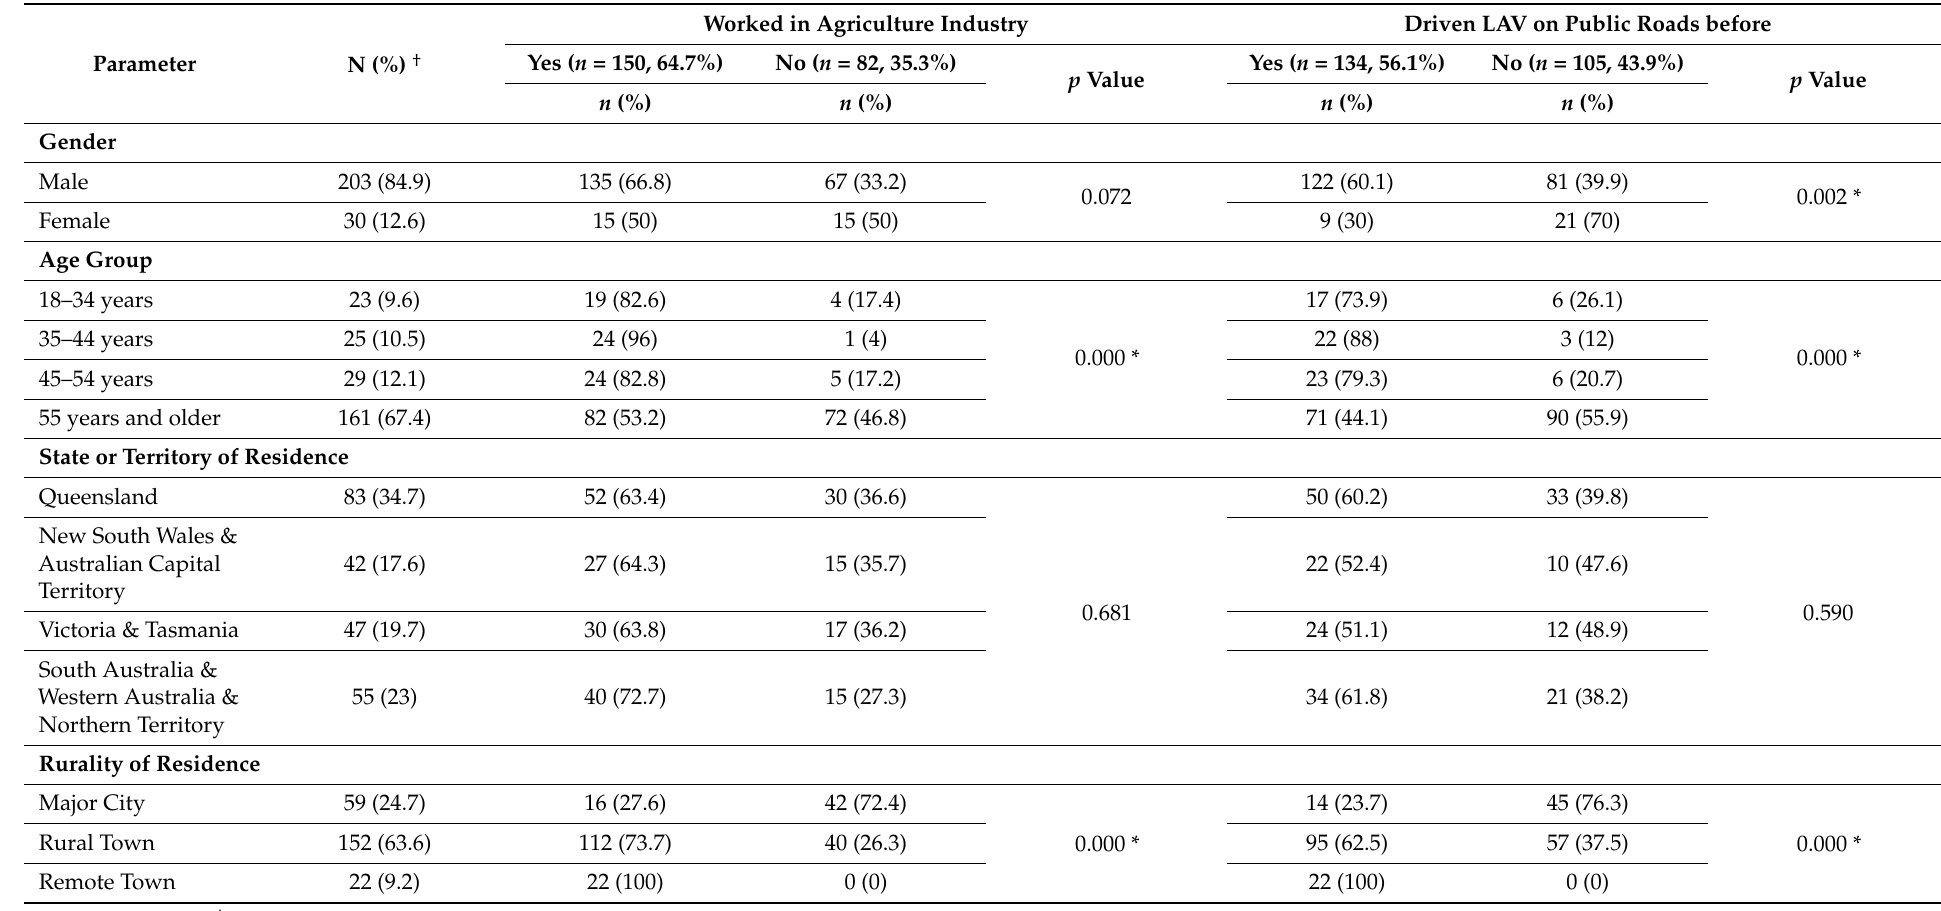
Table 2. Bivariate associations between the demographic variables by the status of the previous/current agricultural industry engagement and experience driving LAV vehicles.